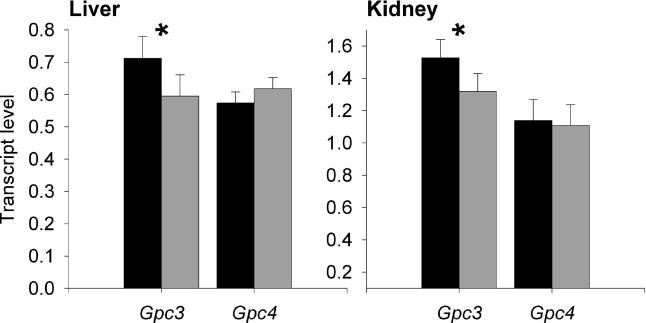
Transcript Levels of Gpc3 and Gpc4 (Divided By β-actin)Expression was measured in newborn liver and kidney in homozygous low-allele females and hemizygous low-allele males (black bars) and in heterozygous females and hemizygous high-allele males (grey bars). Data are from 23 low-allele mice and 24 high-allele males/heterozygous females, and values are least squares means (± 2× standard error); *, p < 0.05.